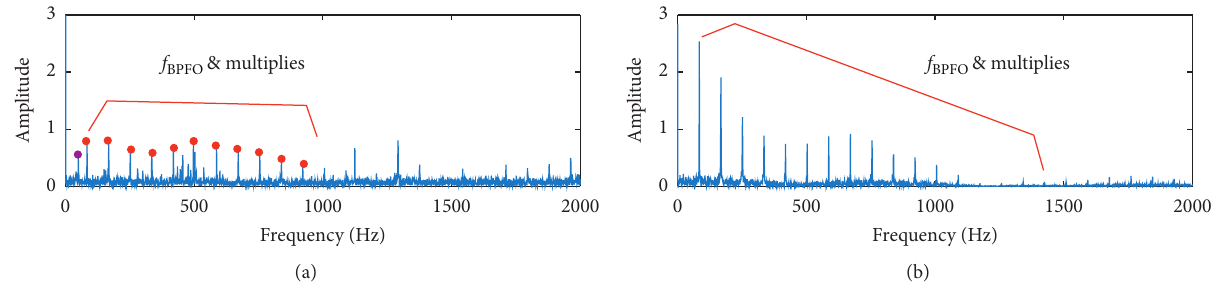
Figure 22: (a) Envelope spectrum of original bearing outer race fault signal and (b) envelope spectrum of signal in Figure 20(e).